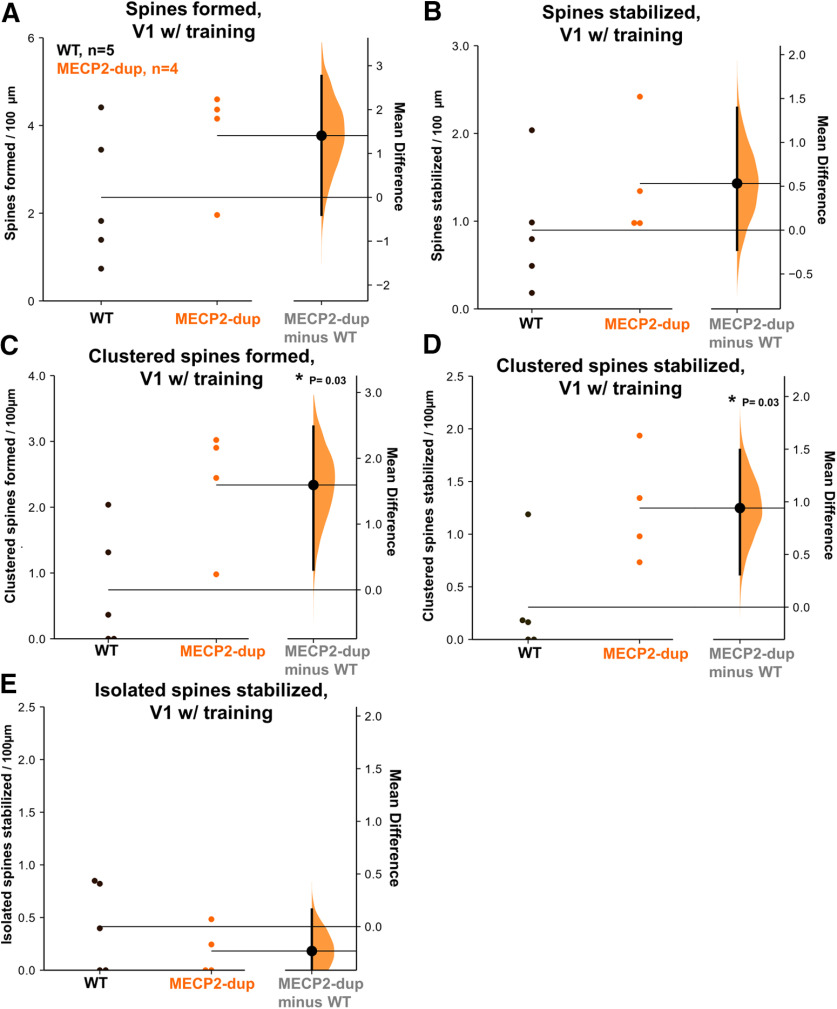
Dendritic spine structural plasticity in visual cortex (V1) in MECP2-duplication mice and littermate controls. A–E, Spine formation and stabilization in visual cortex. Orange, MECP2-duplication. Data are plotted as a Gardner–Altman estimation plot to visualize the results using estimation statistics as in Ho et al. (2019). The left axis of each panel shows individual data points for WT (black) and MECP2-duplication (orange) animals. The right axis shows the bootstrapped distribution (light orange) and 95% confidence interval (vertical black line) of the estimated difference between the two groups. WT: n = 5 mice, 60 spines formed, 33 branches; MECP2-duplication: n = 4 mice, 60 spines formed, 31 branches. All animals in this condition were trained on the rotarod. A, New spines formed between D1 and D5 per 100 μm in visual cortex in each genotype. B, New spines stabilized (still present at D9) per 100 μm in visual cortex in each genotype. C, Clustered spines formed per 100 μm in visual cortex in each genotype; *p = 0.03, Mann–Whitney U test. D, Clustered spines stabilized per 100 μm in visual cortex in each genotype; *p = 0.03. E, Isolated spines stabilized per 100 μm in each genotype. Error bars indicate mean ± SEM.